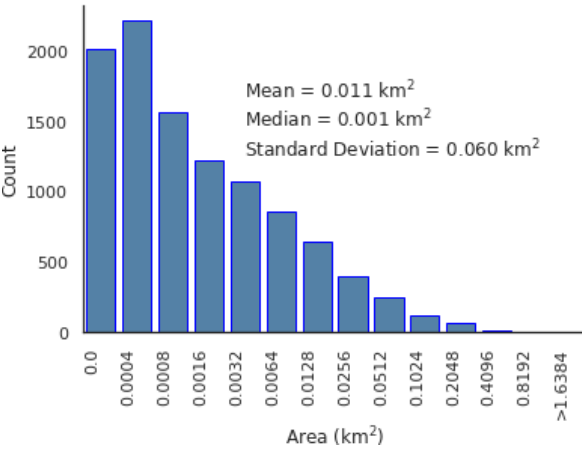
Figure 7. Distribution of SGL and channel area (km 2 ) on WAIS and AP. Note: bin sizes double from left to right. Values for mean, median and standard deviation for the distribution are included in the figure.